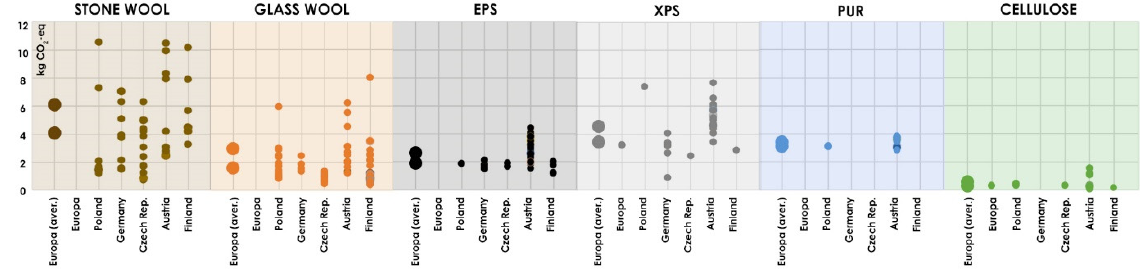
Figure 1. Value of GWP (embodied carbon) for different materials in different locations.